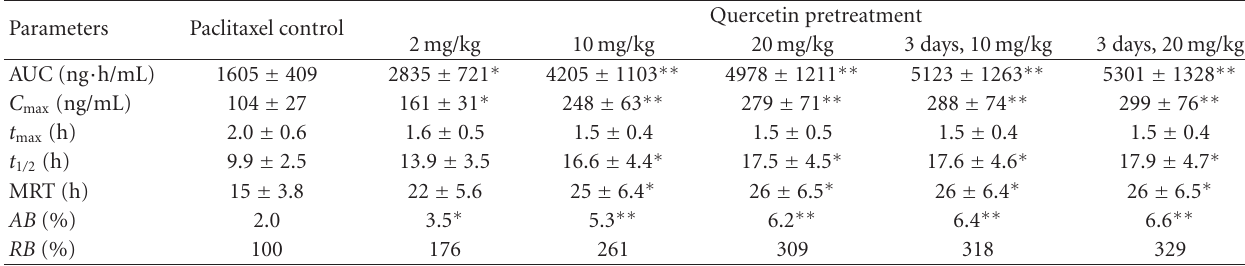
Table 29: Pharmacokinetic parameters of paclitaxel (40mg/kg) and in combination with pretreated quercetin rats after oral administration [218]. Parameters